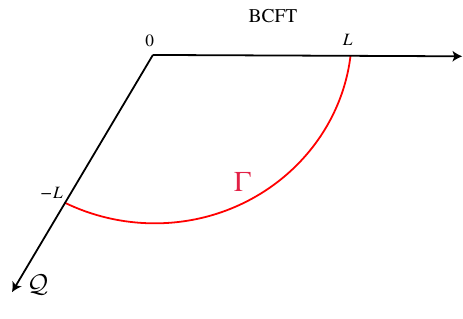
log 2 , and c log 2 3 3